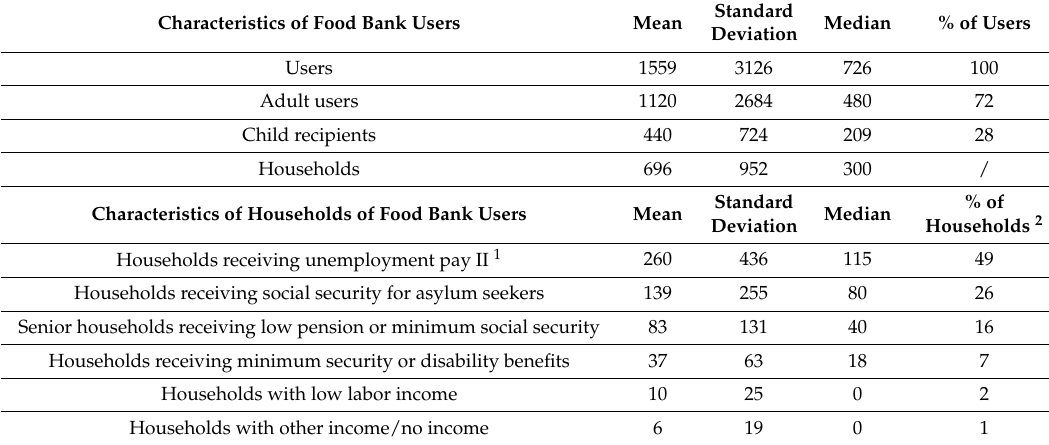
Table 1. Sociodemographic characteristics of food bank users in Germany, 2017.